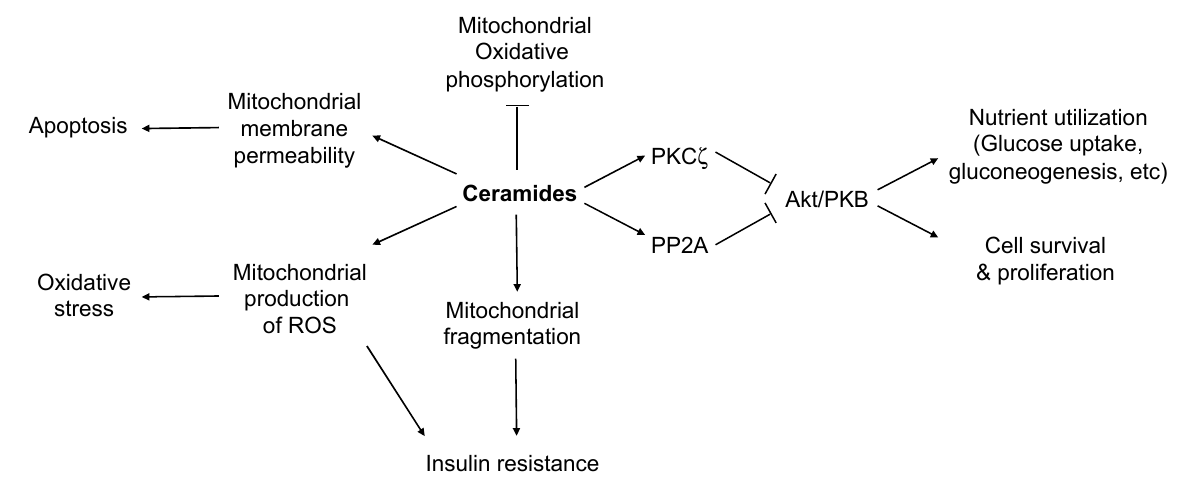
Figure 3. Modes of action of ceramides causing insulin resistance and apoptosis. Ceramides may cause insulin resistance through direct inhibition of the insulin signaling pathway. Elevated C16:0- ceramide is believed to be particularly harmful in causing mitochondrial dysfunction, while elevated C18:0-ceramide has been shown to be a major player in insulin resistance in skeletal muscle. See the main text for details.